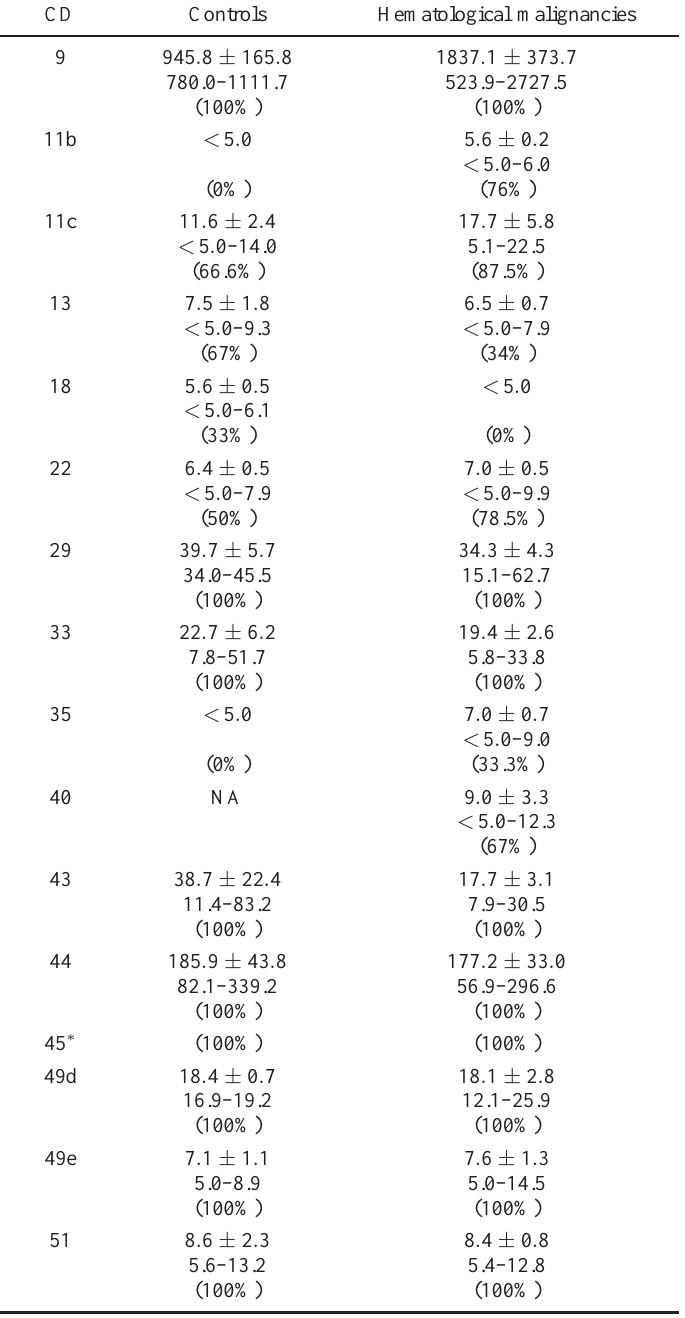
Table 1 Immunophenotypic characteristics of bone marrow mast cells in healthy controls and patients with hematological